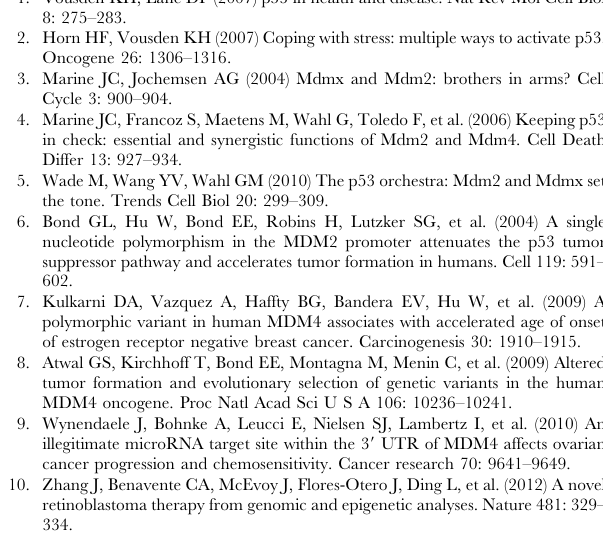
Figure S1 MDM2 and MDM4 Antibody Optimization and Protein Quantification. Recombinant purified